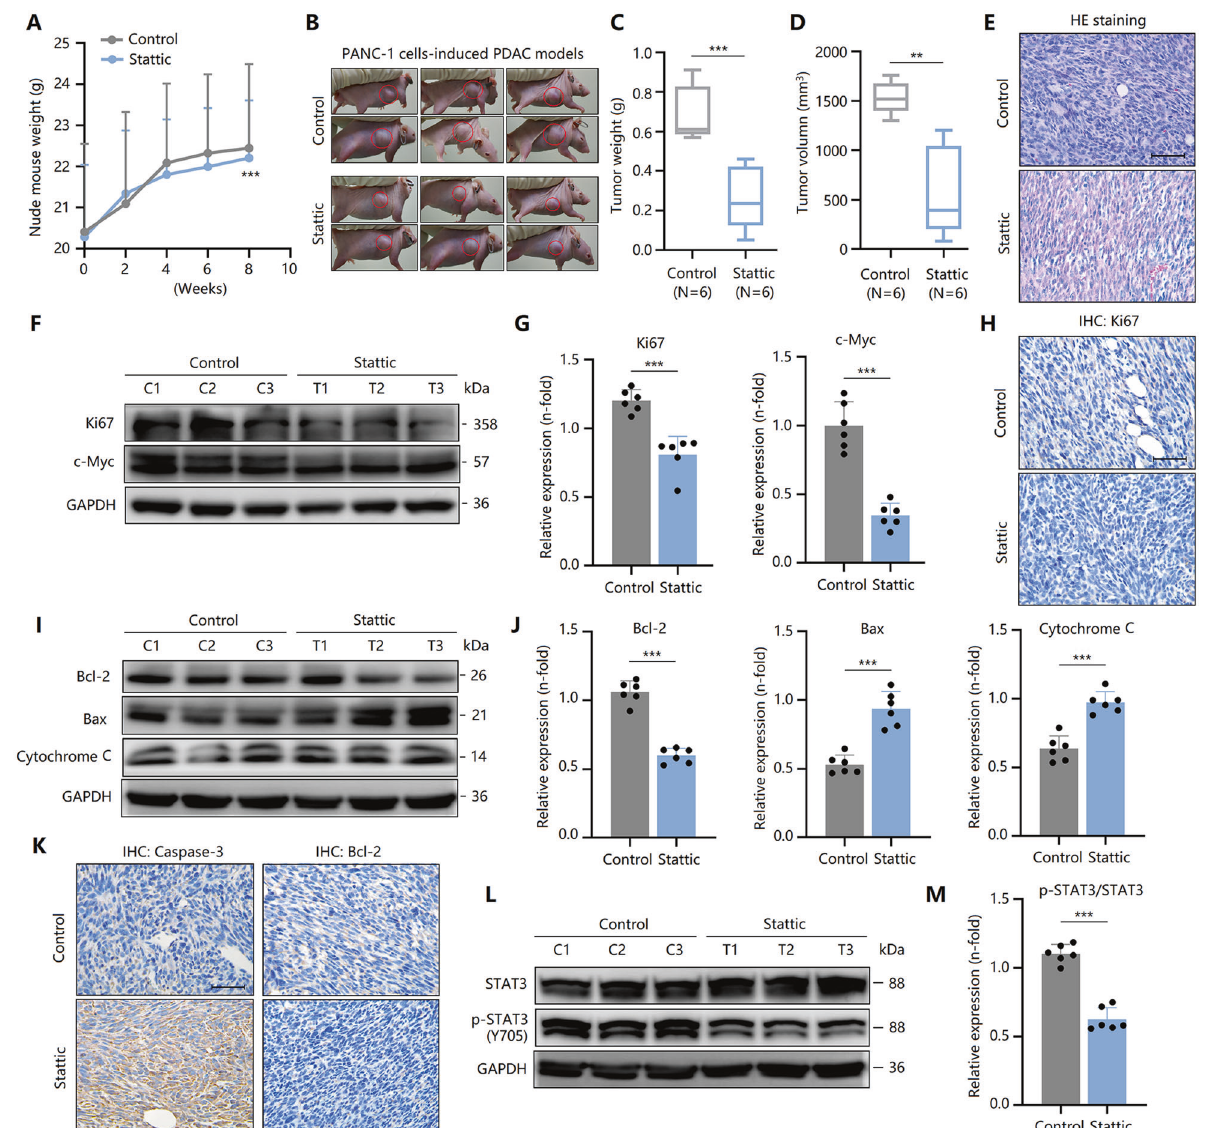
Stattic-treated pancreatic cancer tissues. Bar = 100 μ m. I , J Expression of Bcl-2, Bax, and cytochrome C in Stattic-treated pancreatic cancer tissues. K IHC staining of caspase-3 and Bcl-2 in Stattic-treated pancreatic cancer tissues. Bar = 100 μ m. L , M Expression and